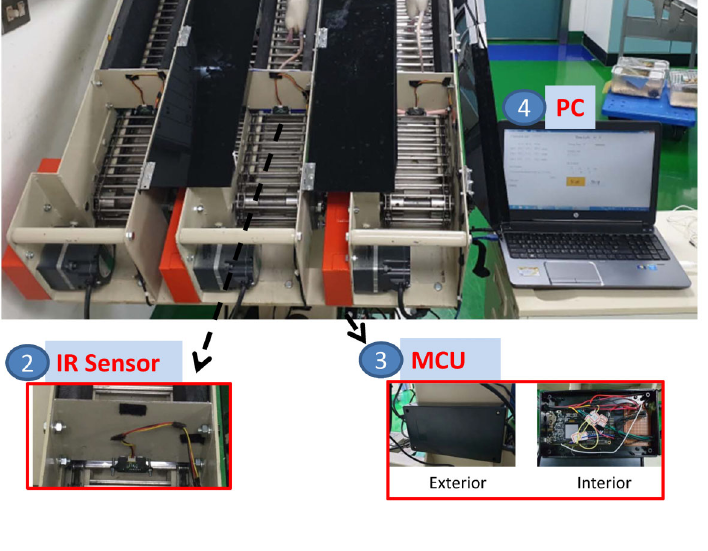
Figure 1. Three-channel automatic speed- matching climbing training system, including 1: ladder body; 2: infrared (IR) distance sensor; 3: microcontroller unit (MCU); and 4: personal com- puter (PC).